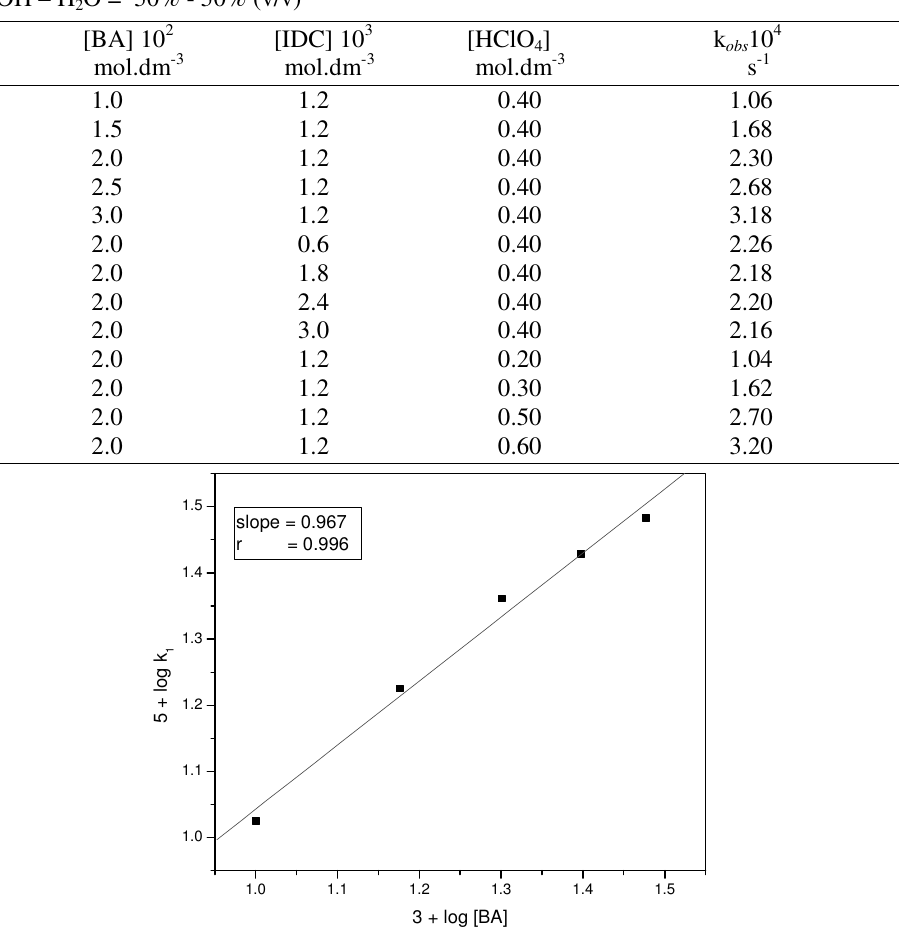
] on the rate reaction at 303 K 4